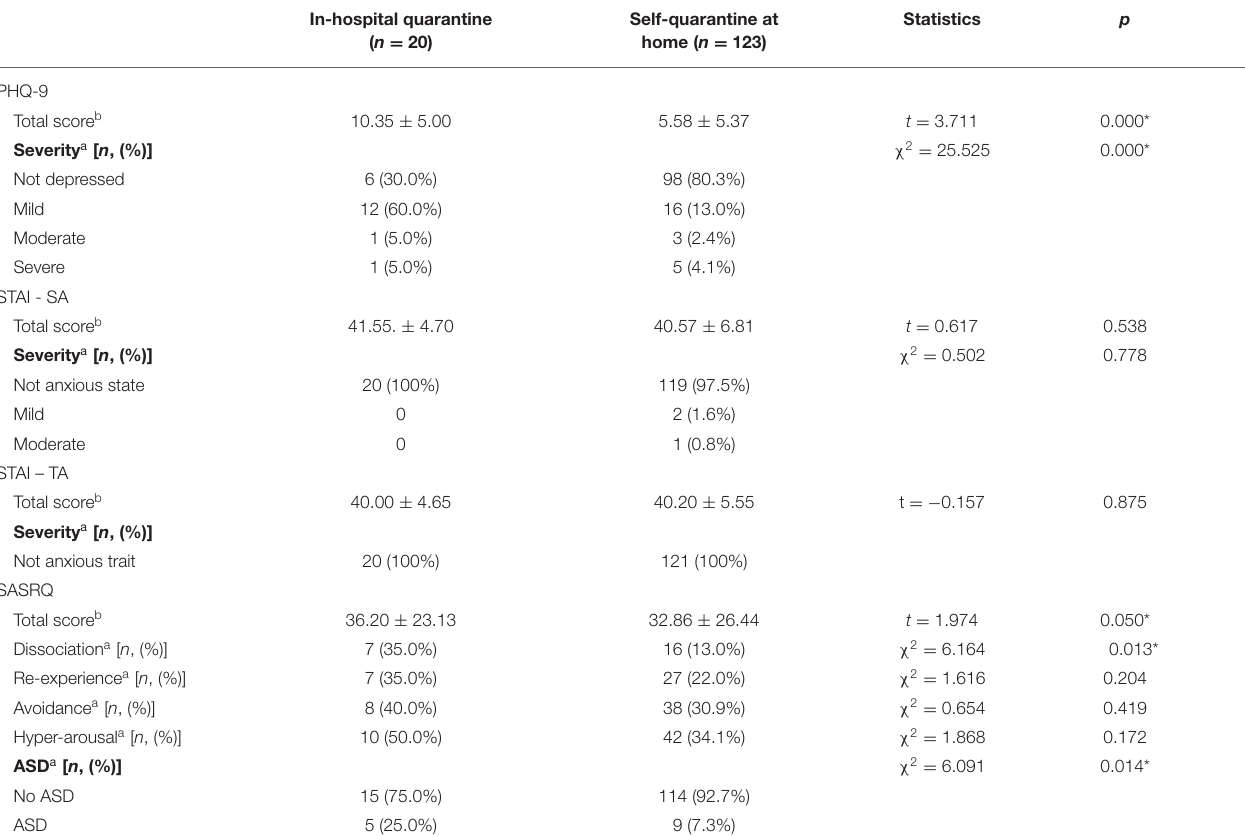
TABLE 2 | Comparison of psychiatric symptoms according to quarantine method.